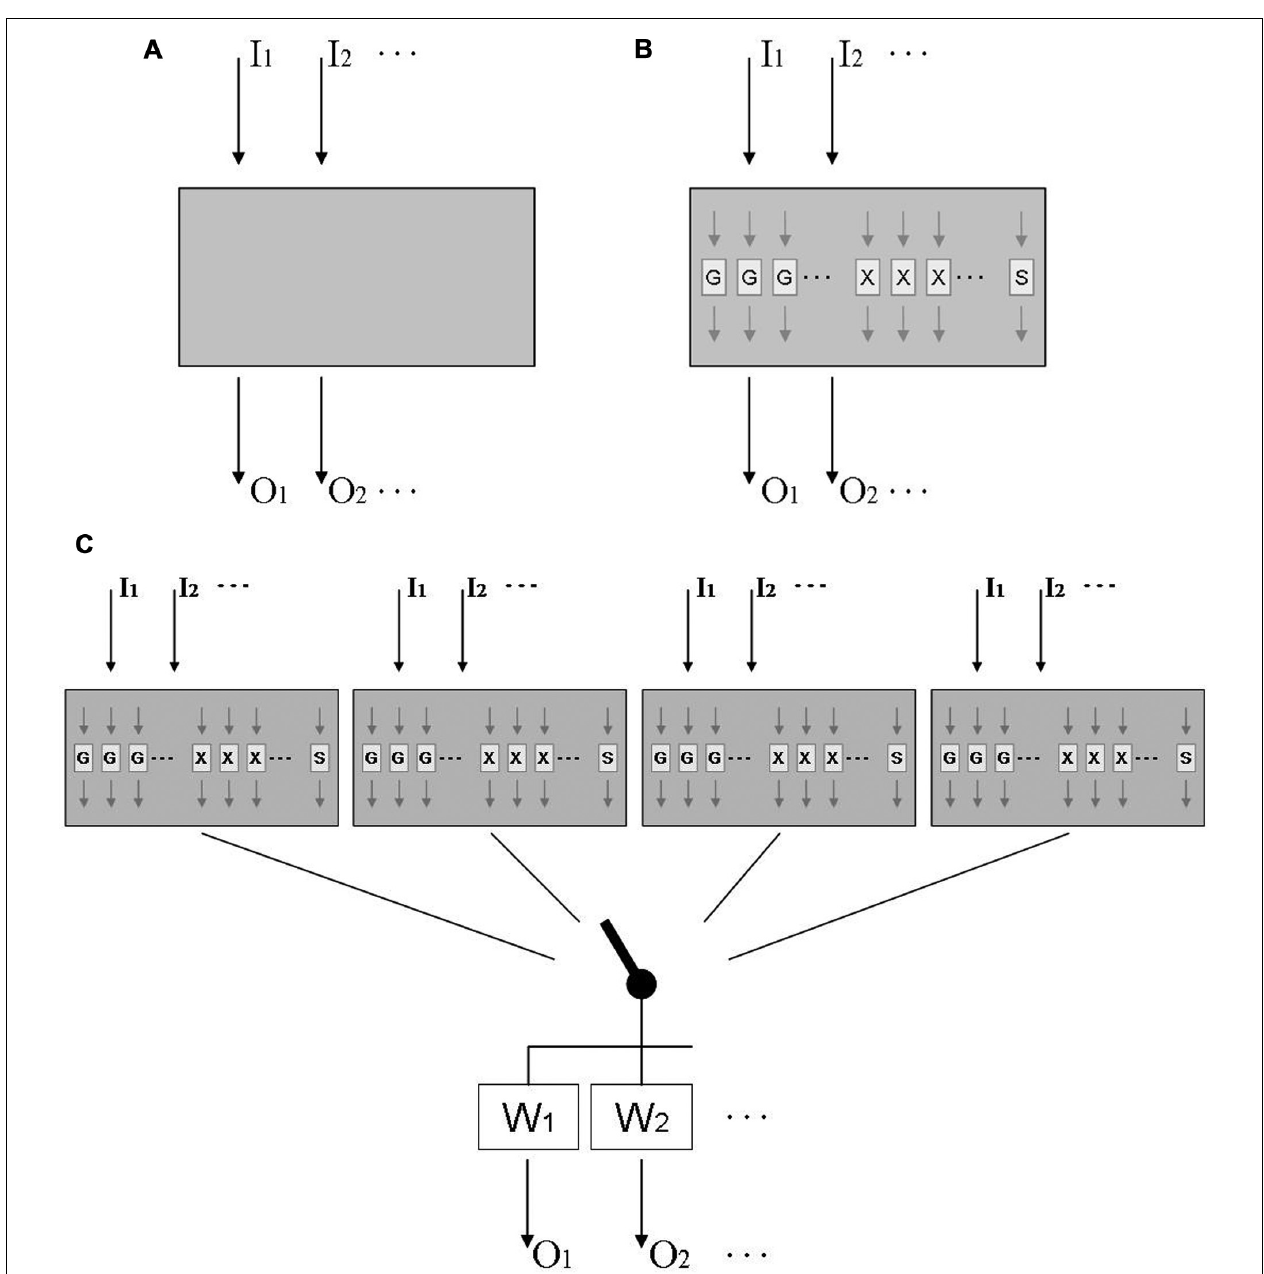
and S for scaling; modules G i and X i are laid out in parallel, each being tuned to a limited range of target directions. (C) Final model that includes multiple mechanisms linked to the motor output by a context-dependent switch, and weighting factors that are higher for practiced than for unpracticed effectors and movement